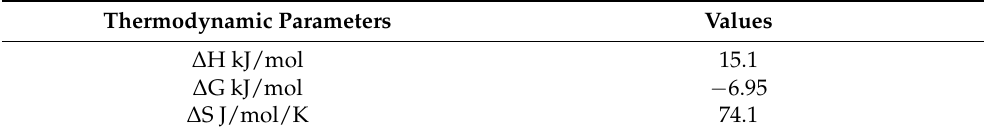
Table 3. Thermodynamic parameters obtained for Cu extraction using Mextral 5640H. Thermodynamic Parameters